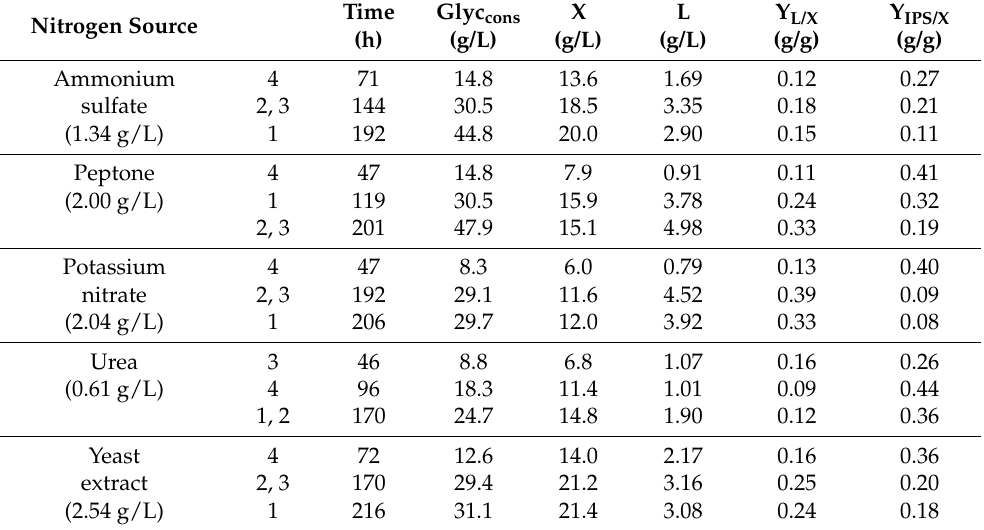
Table 2. Quantitative data of Cryptococcus curvatus strain ATCC 20509 deriving from kinetics on crude glycerol, in nitrogen-limited shake-flask cultures, in which the initial glycerol (Glyc0) was ≈ 50 g/L, and the same initial quantity of nitrogen was imposed, with different nitrogen sources employed (in all trials, yeast extract at an initial concentration of 1.0 g/L has already been employed). Four different points in the fermentations are represented: (point 1) when the maximum quantity of DCW (X, g/L) was observed; (point 2) when the maximum quantity of lipid per DCW (Y L/X , g/g) was observed; (point 3) when the maximum quantity of absolute lipid value (L, g/L) was observed; (point 4) when the maximum quantity of intra-cellular polysaccharides per DCW (Y IPS/X , g/g) was observed. Fermentation time (h) and quantity of glycerol consumed (Glyc cons , g/L) are also depicted for all the above-mentioned fermentation points. Culture condition: growth on 250-mL conical flasks at 180 ± 5 rpm, initial pH = 6.0 ± 0.1, culture pH ranging between 5.2 and 5.8, incubation temperature T = 28 ◦ C. Each experimental point is the mean value of two measurements (SE < 15%). Nitrogen Source